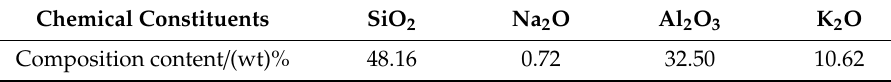
. Figure 1. XRD pattern of muscovite.